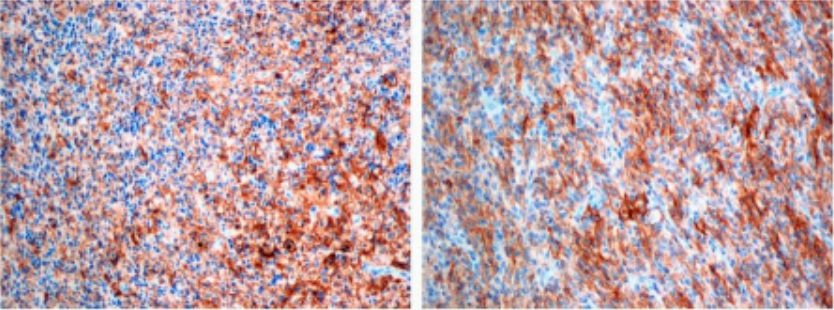
Figure 1. PD-L1 positive staining in p-HGG tumor samples. Magnification 10×.